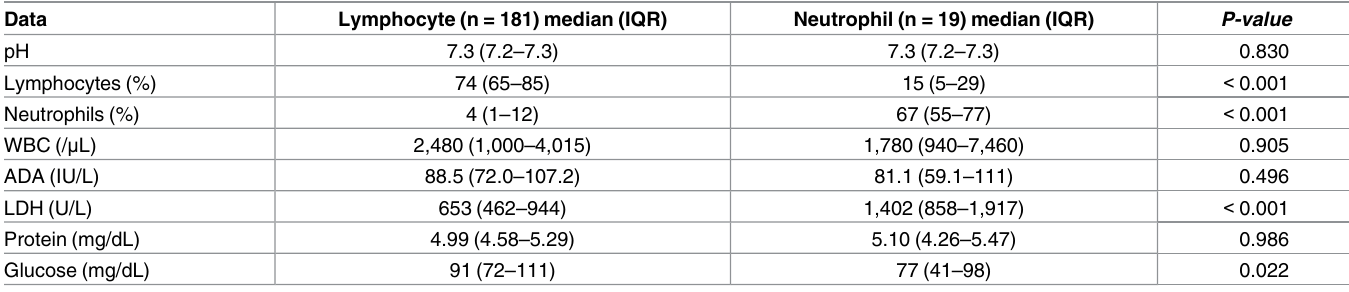
Table 2. Pleural Fluid Analysis of Lymphocyte- and Neutrophil-Predominant Pleural